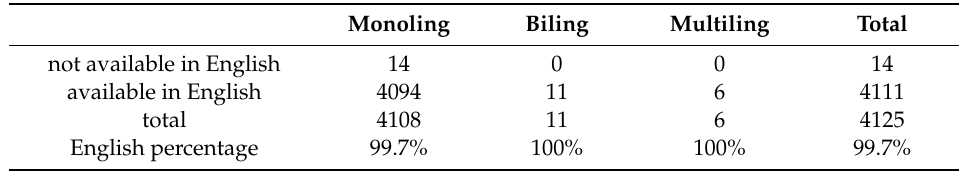
Table A56. English language availability (uk).